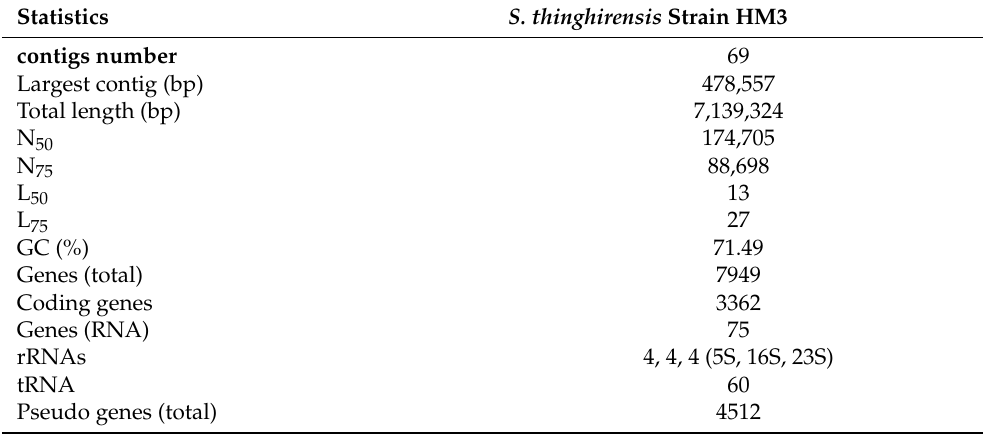
Table 2. General genome features .